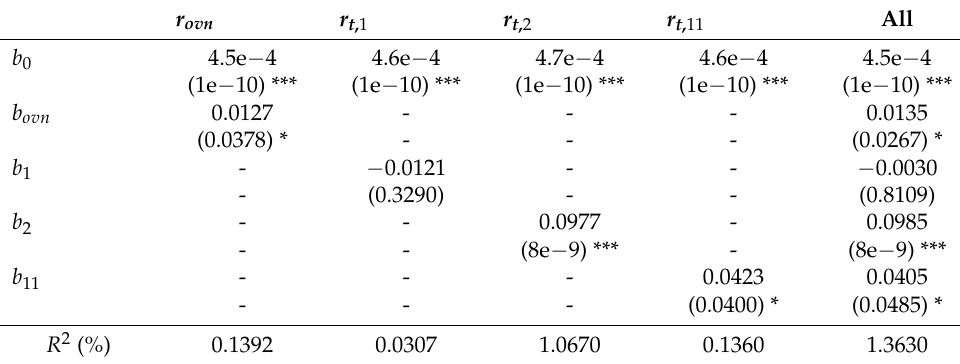
Table 4. Estimation results of Market Intraday Momentum. r ovn r t , 1 All b